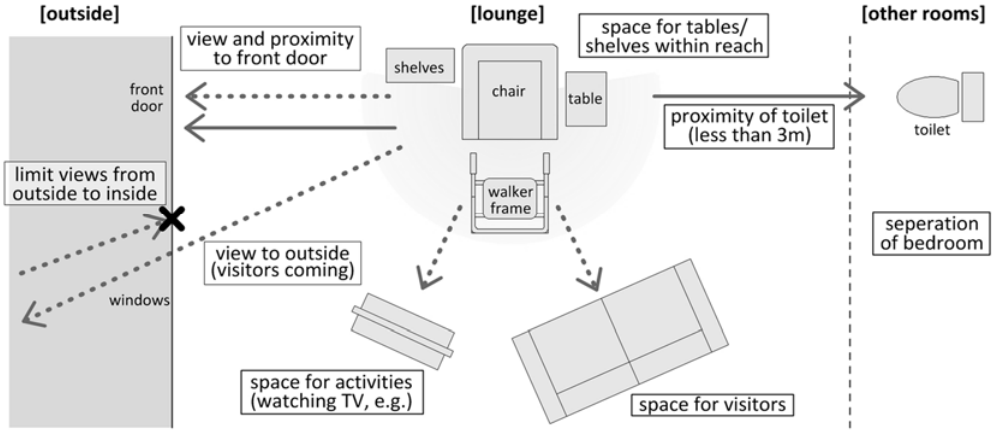
Figure 1. Diagram for spatial organization surrounding the sitting area.